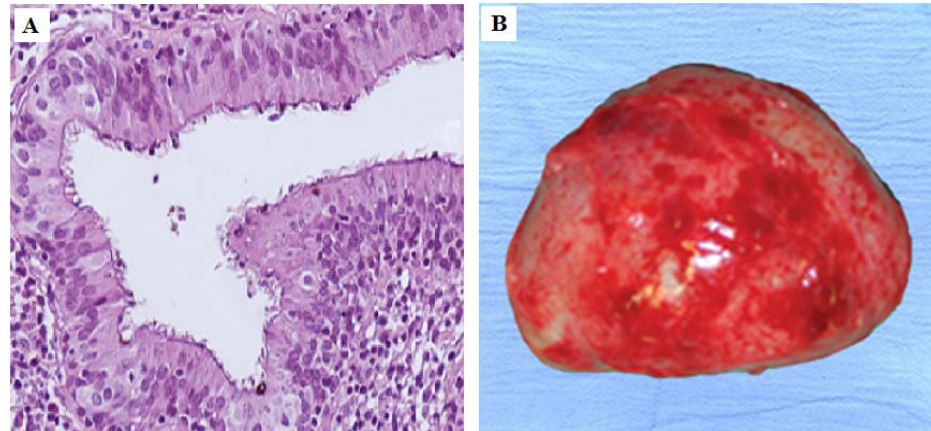
Figure 2. Pathological features of the bronchogenic cyst: (A) Microscopic view (H & E stain) showing a cystic lesion lined by pseudo- stratified ciliated columnar epithelium and contains cartilage. (B) Macroscopic view of oval unilocular cyst has a smooth